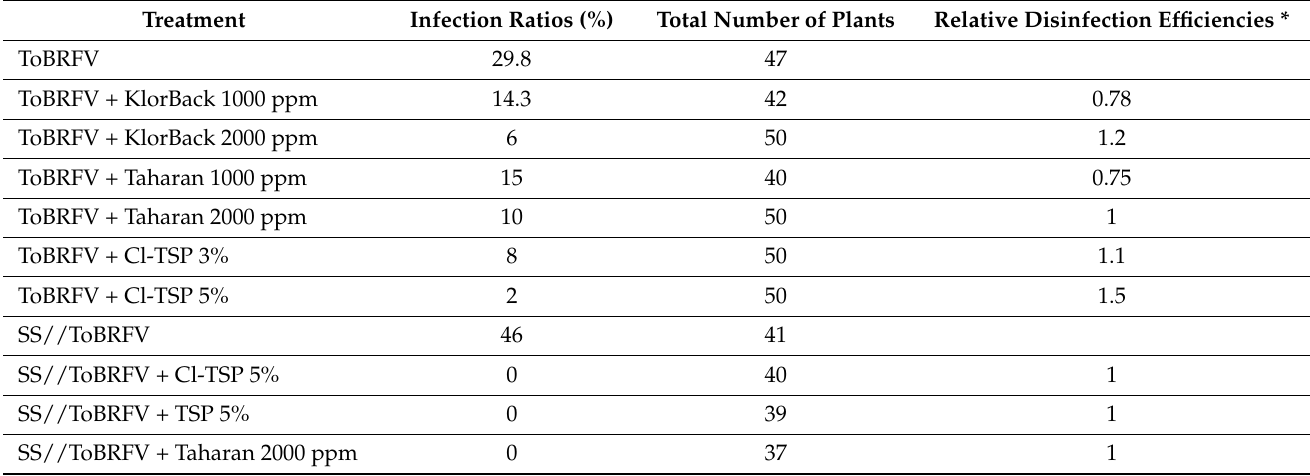
Figure 4. Phytotoxicity of tri-sodium phosphate (TSP)-treated soil: ( a1 , a2 ) inhibition of growth in greenhouse grown cucumber plants exposed to soil disinfection with 10% TSP (left side control plants compared to the right side plants planted in 10% TSP-treated soil); ( a1 ) 7 days post soil disinfection and planting; ( a2 ) 26 days post soil disinfection and planting; ( b ) cucumber plants at five days post exposure to 5–10% TSP. A total of 50 mL of 5–10% TSP were poured into the planting pits before cucumber seedlings without root truncation were planted; ( c1 ) tomato plants at five days post exposure to 5–10% TSP. A total of 50 mL of 5–10% TSP were poured into the planting pits before tomato seedlings without root truncation were planted; ( c2 ) a strong phytotoxic effect of burning-yellow spotted leaves on a tomato plant grown in 10% TSP-treated soil for 48 h; ( c3 ) a control tomato plant, planted in untreated soil, at 48 h post planting. Table 3. Relative disinfection efficiencies of ToBRFV- and CGMMV-infested heavy or sandy